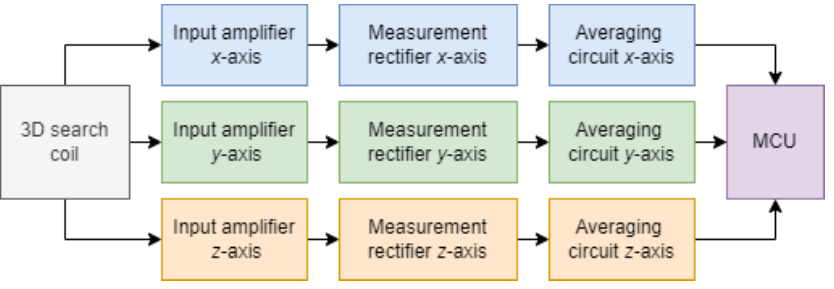
Figure 4. Block scheme of the measurement system.